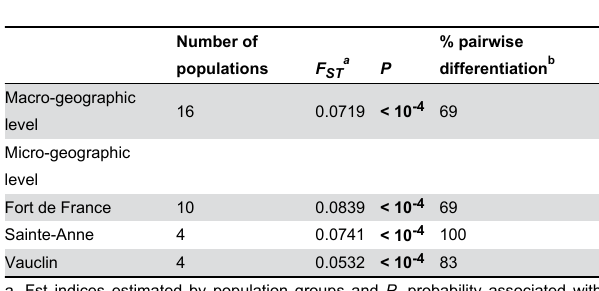
3. Genetic differentiation estimated with 6 microsatellite markers at two geographic levels.